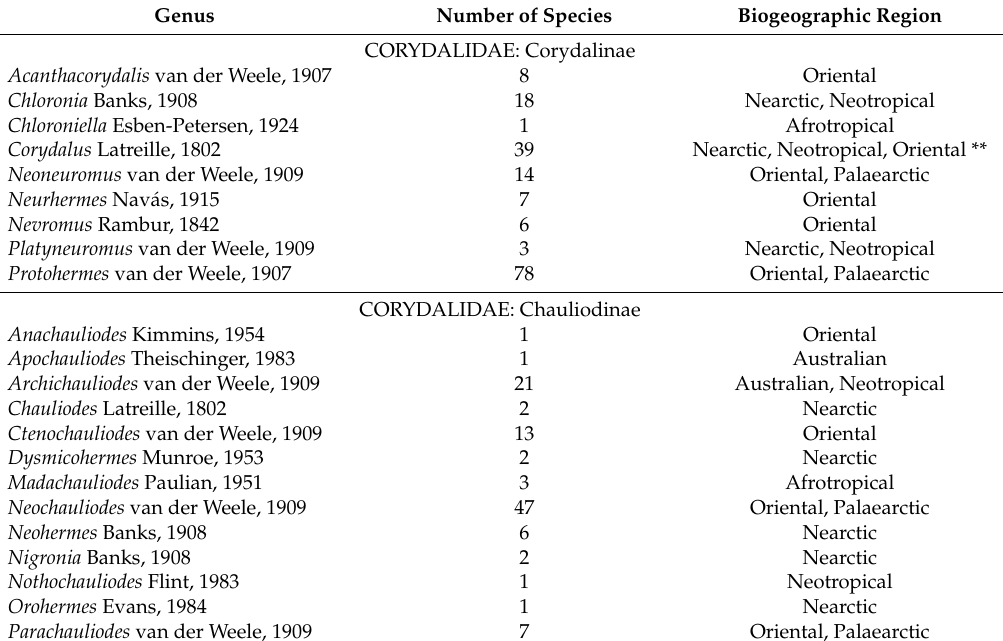
Table 1. Genera of Megaloptera with extant valid species (* = includes subspecies, ** = possible erroneous combination of an Oriental